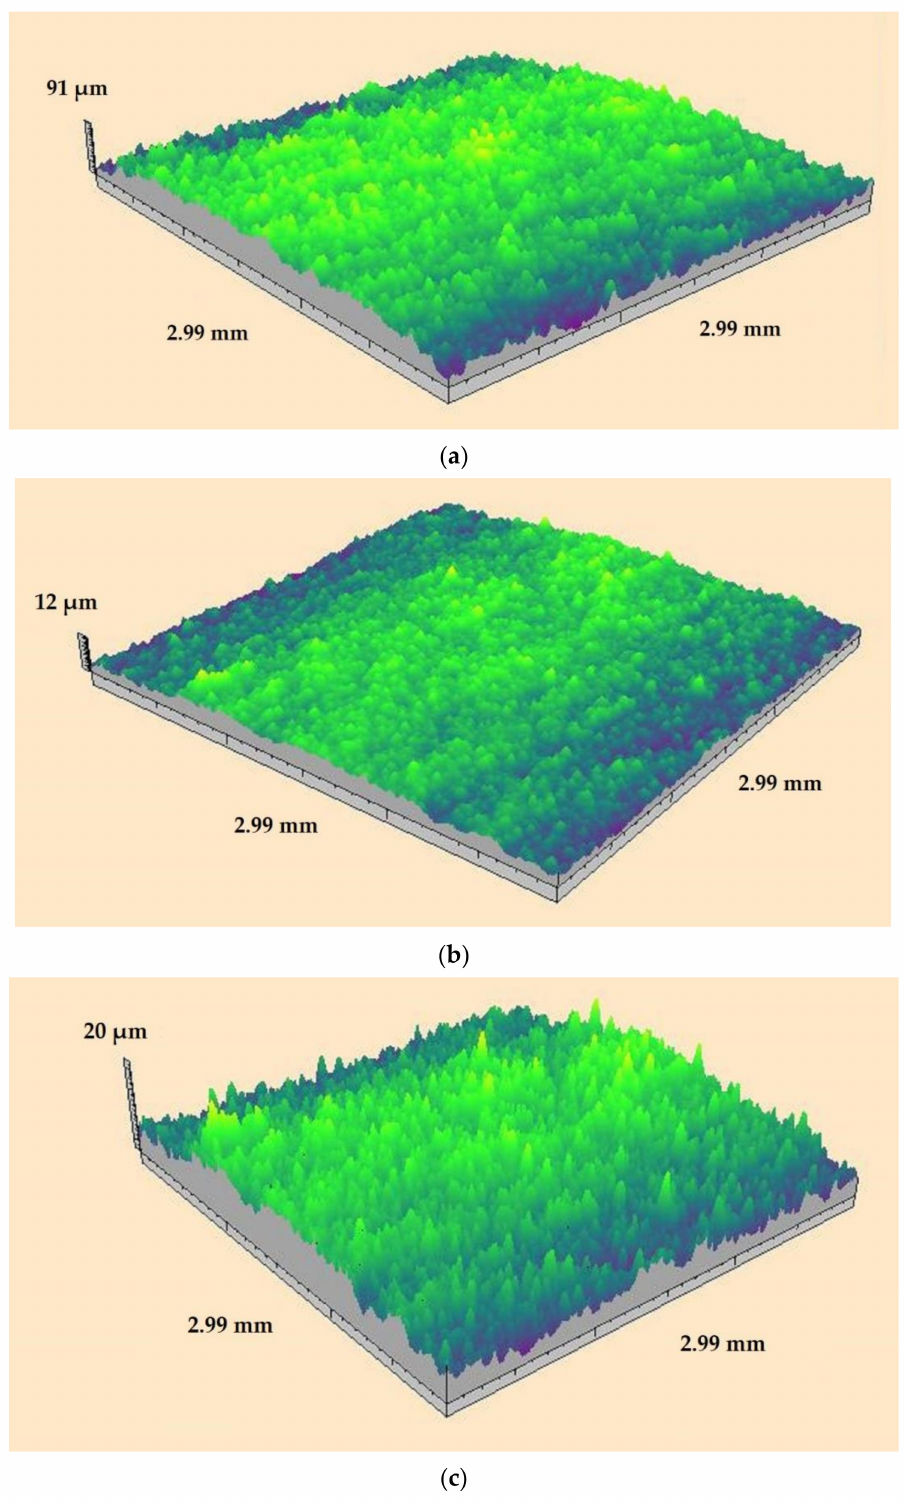
Figure 6. 3D microroughness of the 20Kh13 (DIN 1.4021) steel samples before and after various types of postprocessing: ( a ) after processing; ( b ) after cavitation-abrasive finishing; ( c ) after plastic